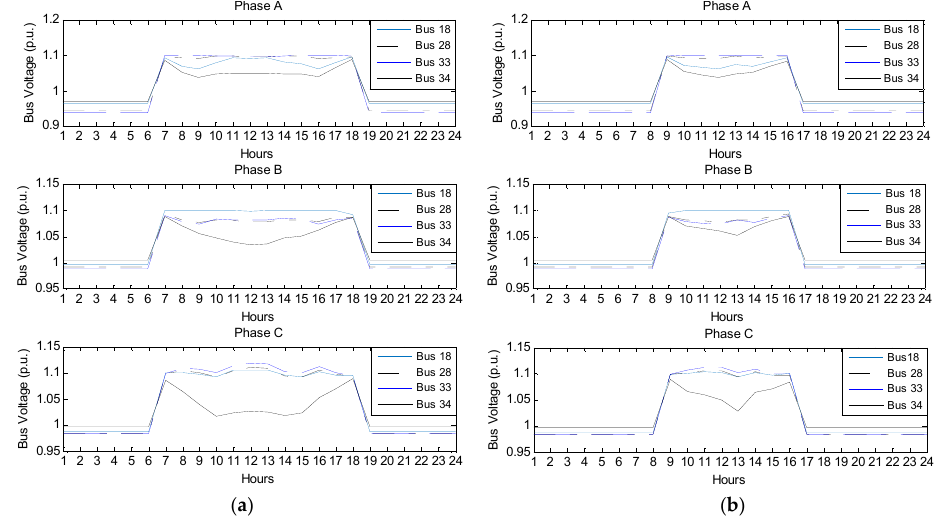
Figure 12. Variation of feeder end bus voltage at base load conditions with low solar radiation pro- file. ( a ) Summer day—4th July. ( b ) Winter day—31st December.